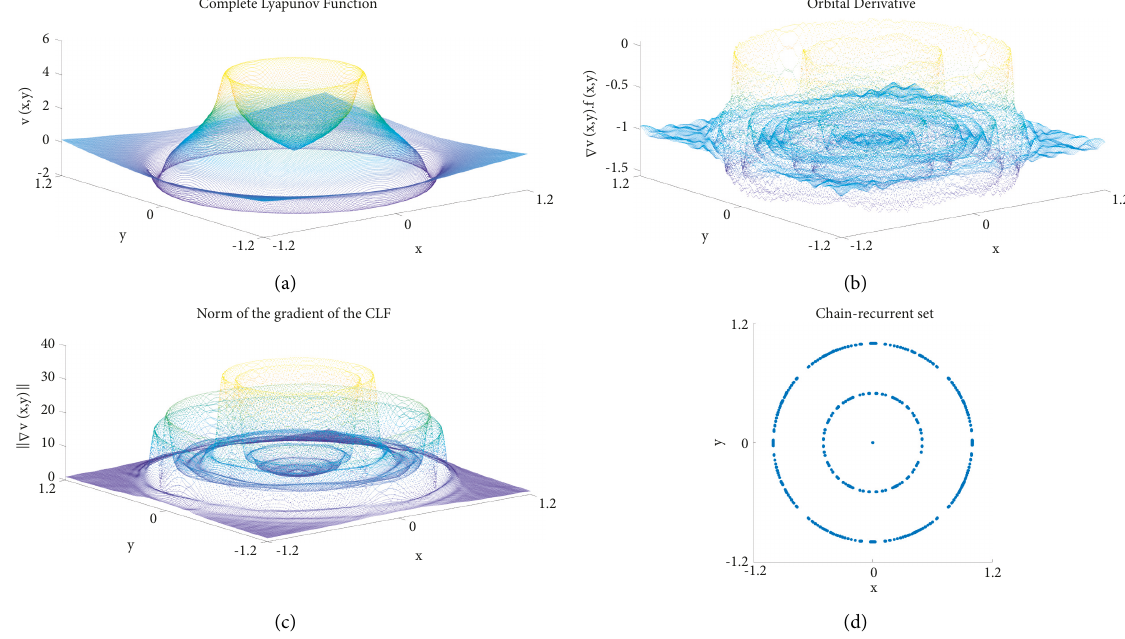
Figure 5: System (19). (a) Complete Lyapunov function v . (b) Its orbital derivative v ′ . (c) Norm of its gradient ‖ ∇ v ‖ . (d) Underestimation of the chain recurrent set C v, 0 . 8